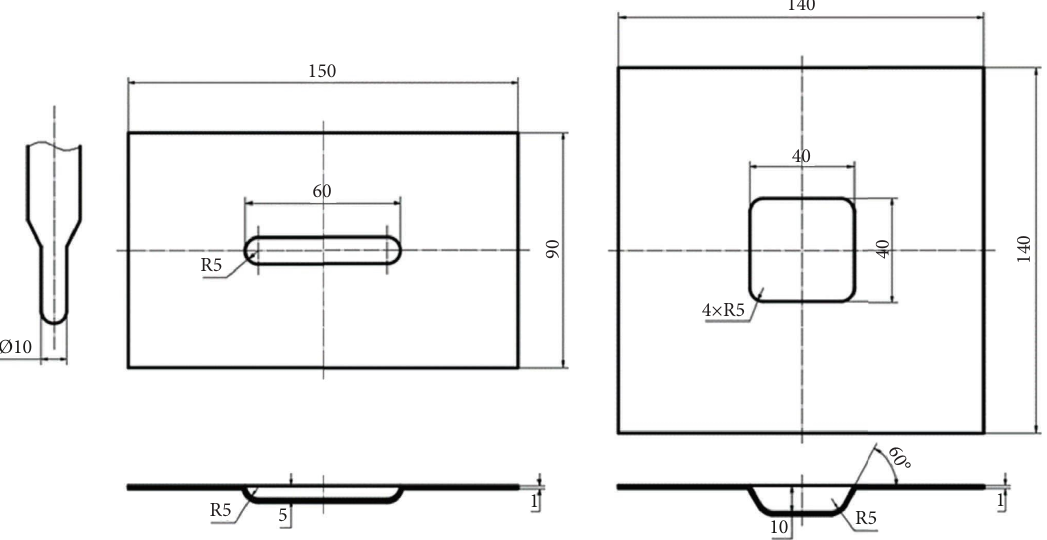
Figure 2: Dimension of tools and part in the simulations.